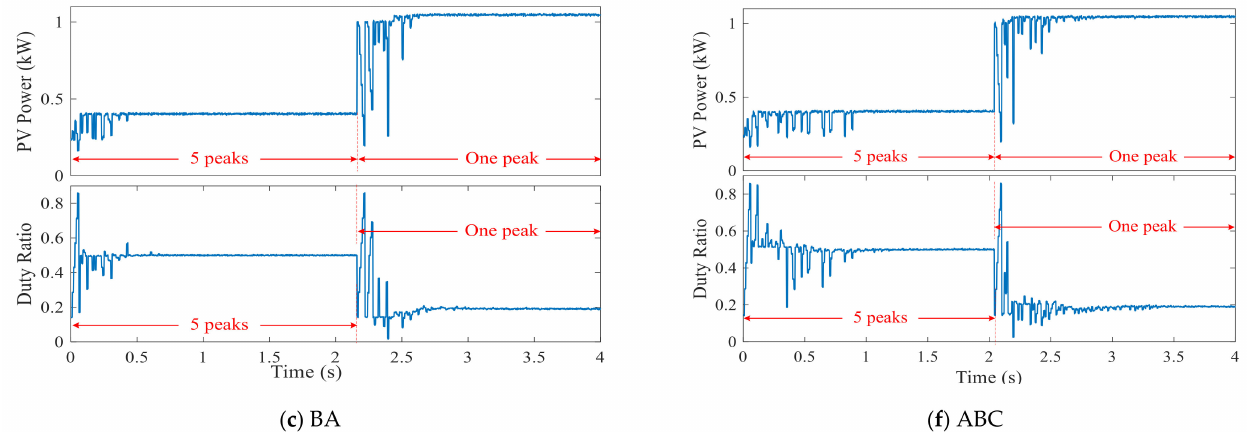
Figure 14. The experimental results showing the time variation of generated power and duty ratio of boost converter for all SOTs at 1 peak and 5 peaks, respectively.